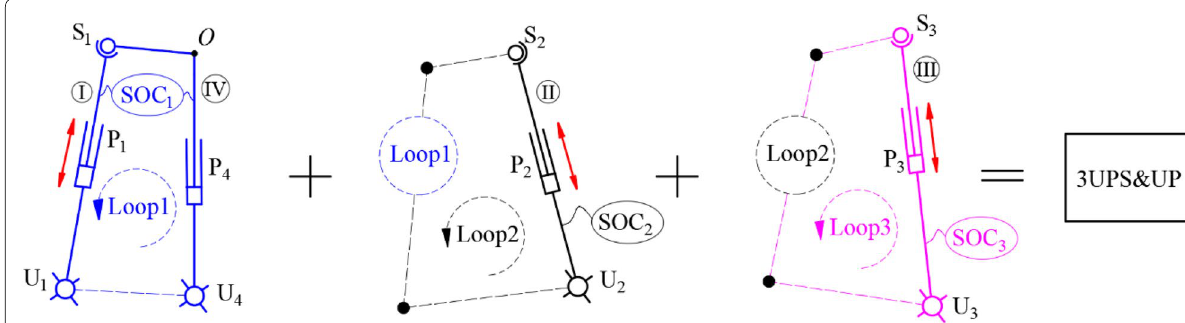
Figure 4 Decomposition of the 3UPS&UP